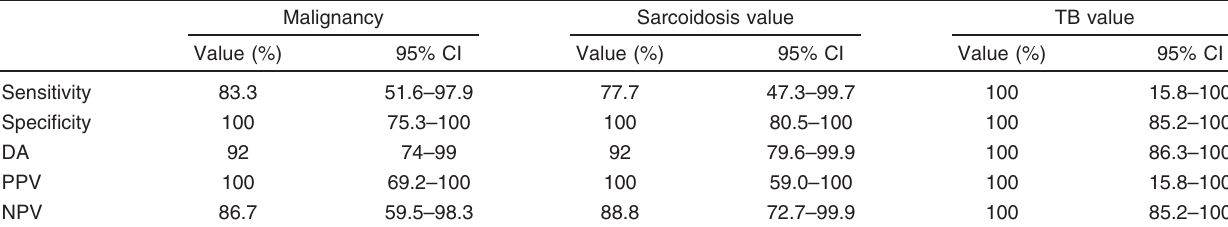
Table 7 Diagnostic validity of endobronchial ultrasound-guided transbronchial needle aspiration in diagnosis of malignancy, sarcoidosis, and tuberculosis